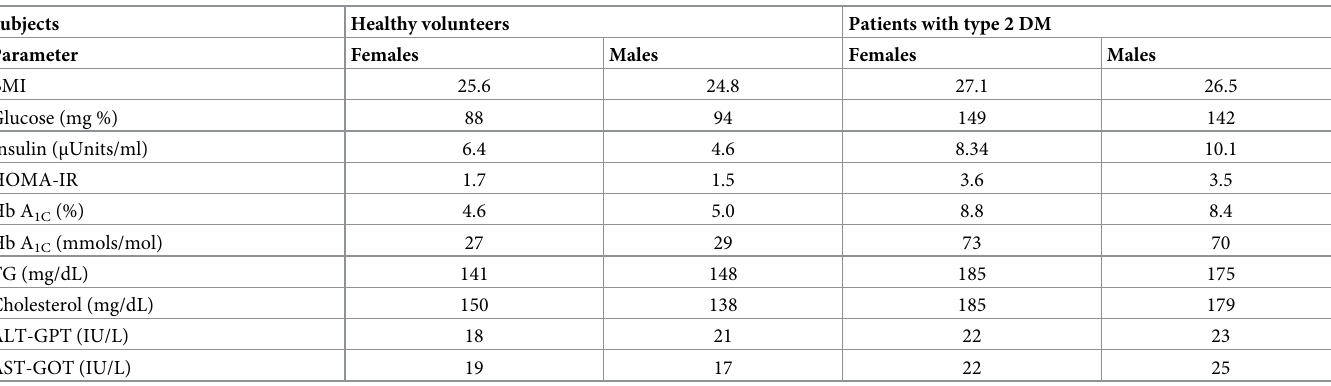
Table 1. Clinical parameters in control subjects and in female and male patients with type 2 DM.